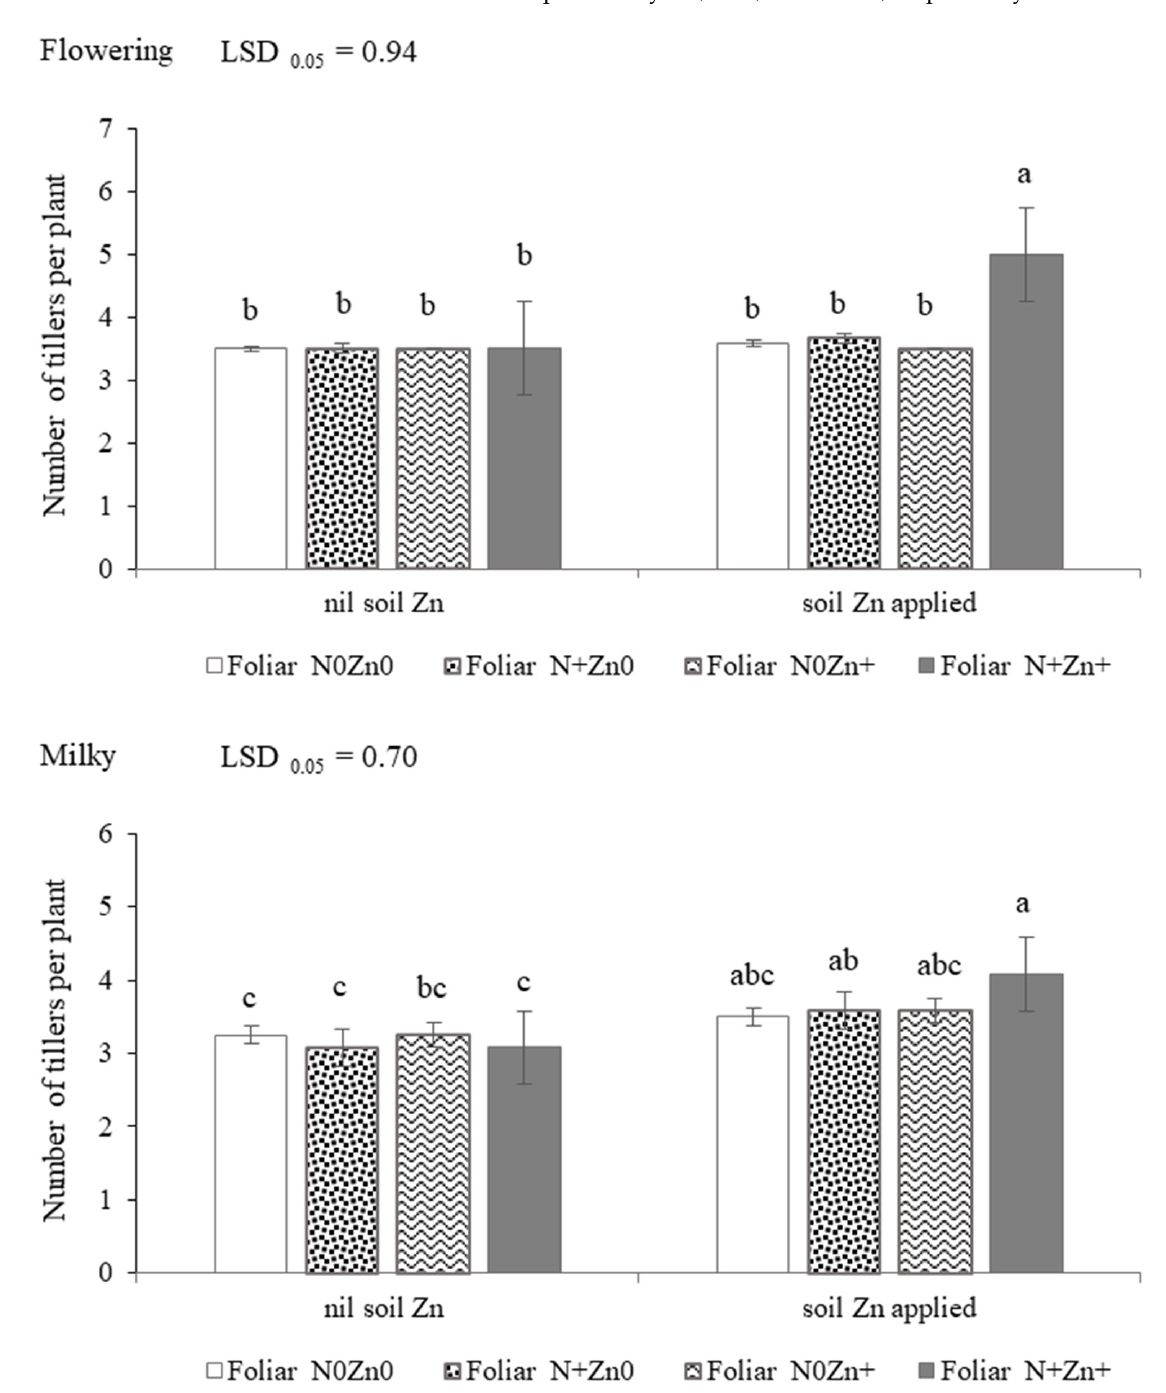
Figure 3. Number of tillers per plant of the SPT1 rice variety grown at different foliar N and Zn fertilizer rates under two soil Zn treatments at the flowering and milky stages. Each value is the mean of four independent replications. Different letters above the bars indicate a significant difference by LSD (0.05). The error bars indicate the standard deviation of each treatment mean (SD) ( n = 4).